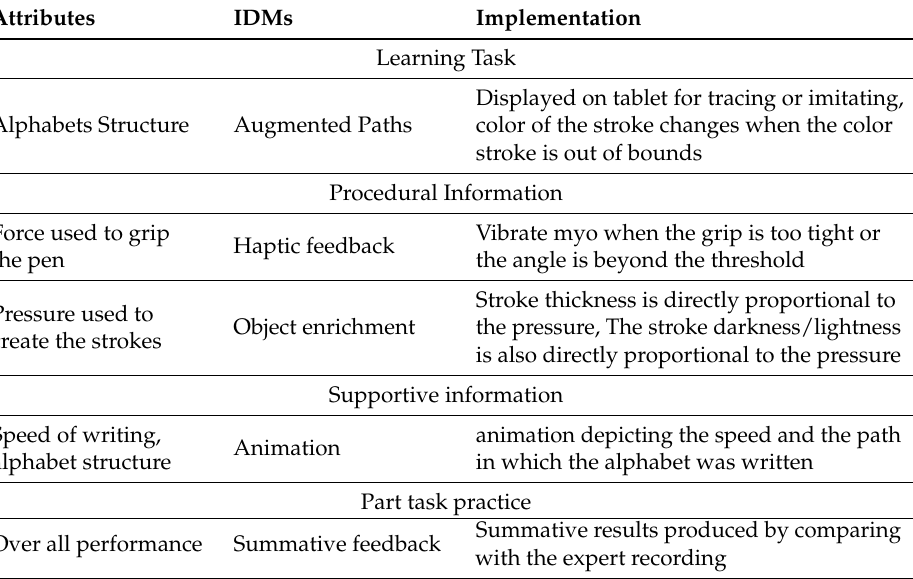
Table 2. Mapping of attributes with IDMs in Calligraphy